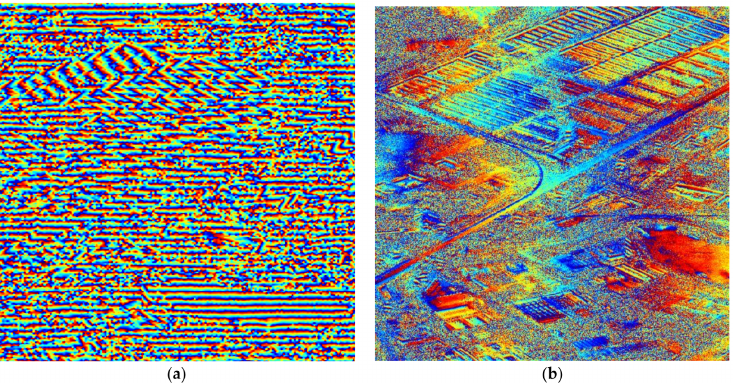
Figure 11. Some results of repeat-pass SAR interferometry experiment. ( a ) The interferogram of the spot marked with the white box in Figure 10; ( b ) The flattened interferogram of ( a